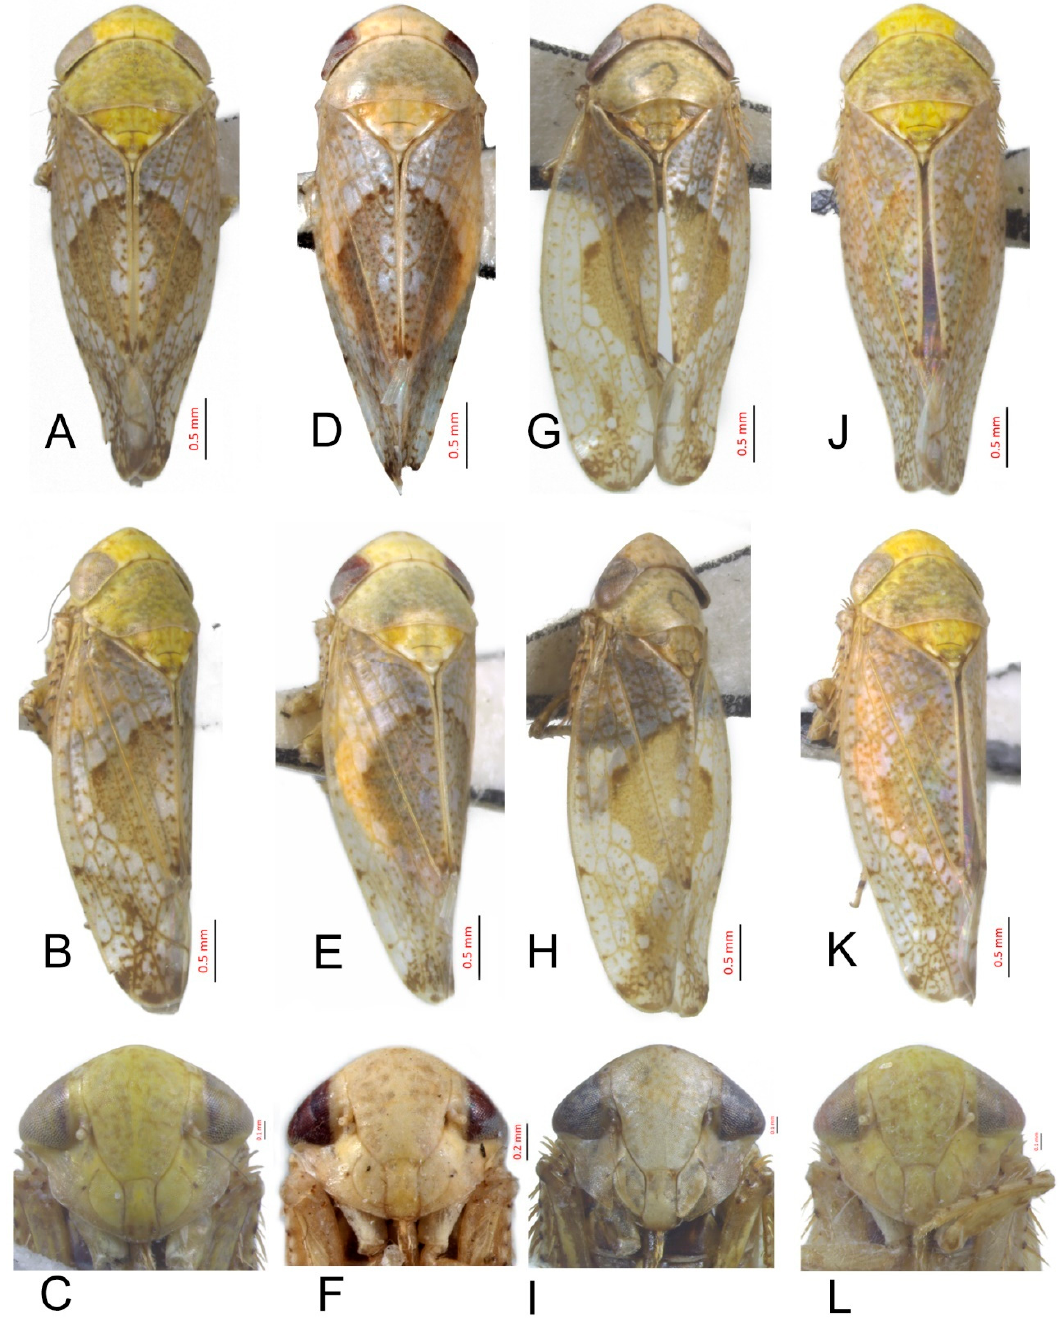
Figure 3. Species of Hishimonus . ( A – C ) H. di ff ractus ; ( D – F ) H. expansivus ; ( G – I ) H. ventralis ; and ( J – L ) H. hamuleus . ( A , D , G , J ) Dorsal view; ( B , E , H , K ) latero-dorsal view; and ( C , F , I , L ) Face.